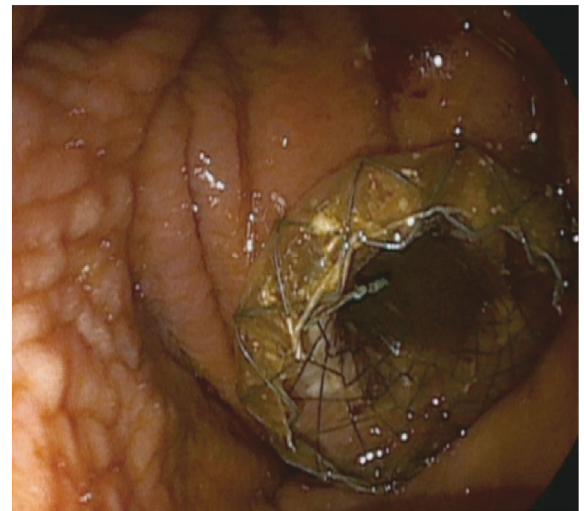
Figure 3: Passive transmural (transgastric) drainage of a postin fl ammatory pancreatic pseudocyst with a self-expanding stent.